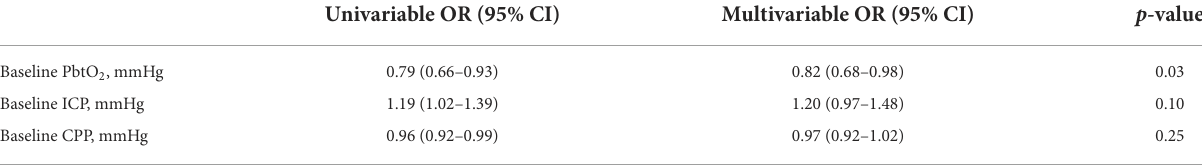
TABLE 2 Logistic regression multivariable analysis to predict a significant PbtO 2 increase after inotropic